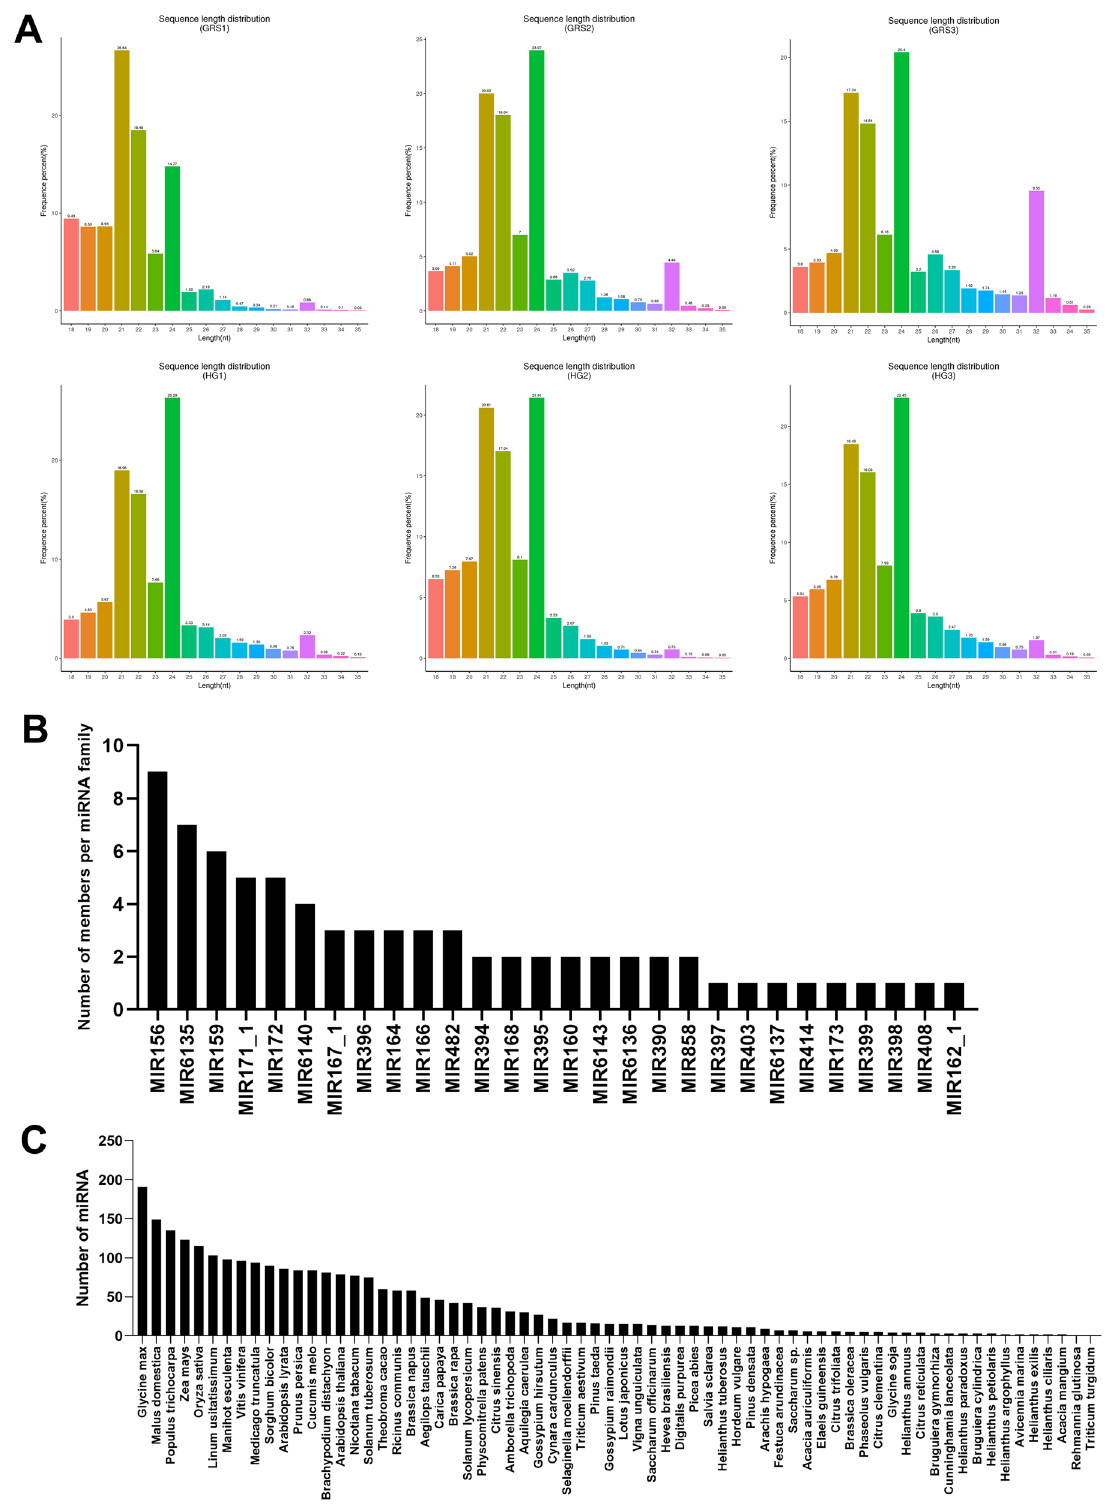
Figure 3. Identification results and characteristics of miRNA. ( A ) Statistics of length distribution of sRNA fragments obtained; ( B ) miRNA family statistics of miRNAs in ginseng tissue; ( C ) statistics of miRNA in ginseng tissue in other species. Image generated with R 3.6.3 (https:// www.R- proje ct. org) 51 ggplot2 package (https:// ggplo t2. tidyv erse.